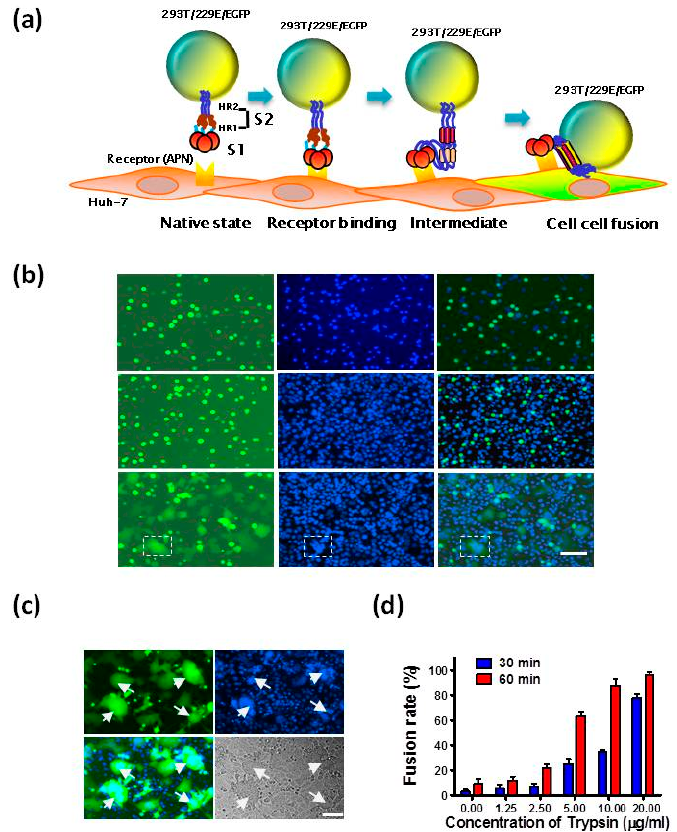
Figure 3. Establishment of HCoV-229E S protein-mediated cell-cell fusion assay. ( a ) Schematic representation of HCoV-229E S protein-mediated cell-cell fusion. 293T cells expressing the S protein on cellular surface and Enhanced Green Fluorescent Protein (EGFP) in cytoplasm (293T/MERS/EGFP) and Huh-7 cells expressing the receptor aminopeptidase N (APN) were used as the effector and target cells, respectively; ( b ) 293T/MERS/EGFP cells alone (upper), Huh-7 cells and 293T/EGFP (middle) or Huh-7 cells and 293T/MERS/EGFP cells (lower) were cultured or cocultured at 37 °C for 3–6 h, stained with 4 ′ ,6-diamidino-2-phenylindole (DAPI), and then photographed under an optical microscope with fluorescence (left) and DAPI (middle). The figures in left and middle panels were overlapped (right). The area encircled by the white dotted line is the fused cell; ( c ) After coculture at 37 °C for 24 h, the fused cells were photographed under fluorescence microscopy (upper left) and DAPI (upper right). The overlap picture (bottom left) shows that each of the fused cells contains two or more nuclei. The bottom right image was photographed under visible light. The arrows point to the fused cells; ( d ) The fusion rate of HCoV-229E S-mediated cell-cell fusion in the absence and presence of trypsin at different concentrations. Data are means ± standard deviation (SD) of triplicate samples from a representative experiment. Scale bars, 800 µm.